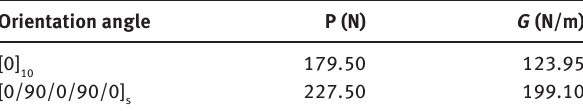
Table 3 Critical load and energy release rate amount for the carbon/epoxy laminate (AS4/3501-6) in mode I testing.